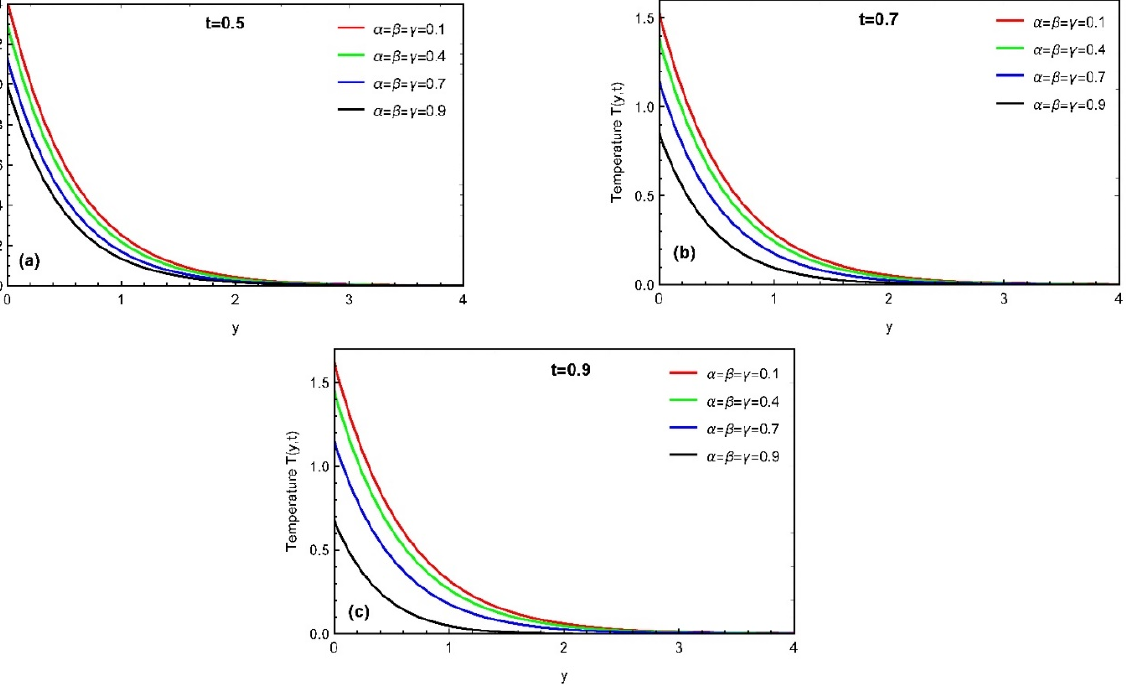
Figure 2. Variation in temperature due to fractional constraints at ( a ) 𝑡 = 0.5 ( b ) 𝑡 = 0.7 ( c ) 𝑡 = 0.9 .